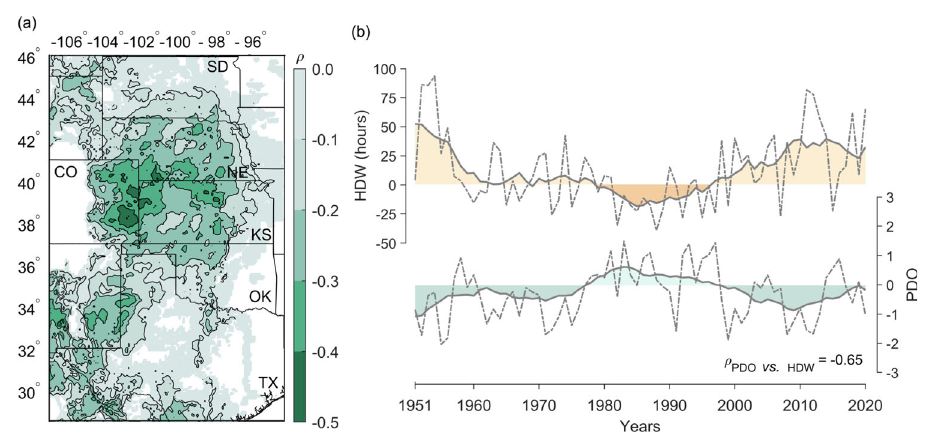
Fig. 4 | The partial Spearman ’ s rank correlation coef fi cient between Paci fi c Decadal Oscillation (PDO) and hot-dry-windy (HDW) anomalies (after detren- ded)duringApril-Junefrom1951to2020inourstudydomainsincludingSouth Dakota (SD), Nebraska (NE), Colorado (CO), Kansas (KS), Oklahoma (OK), and Texas(TX).a Thespatialcorrelationcoef fi cientbetweenPDOandHDWanomalies where the temperatureeffectwas controlled. b Time series of both PDO and HDW